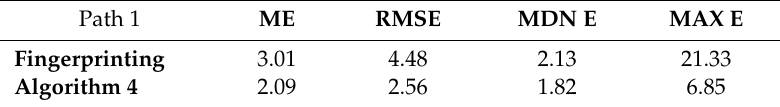
Table 2. Summary of test results for dynamic localization algorithms–path 1.